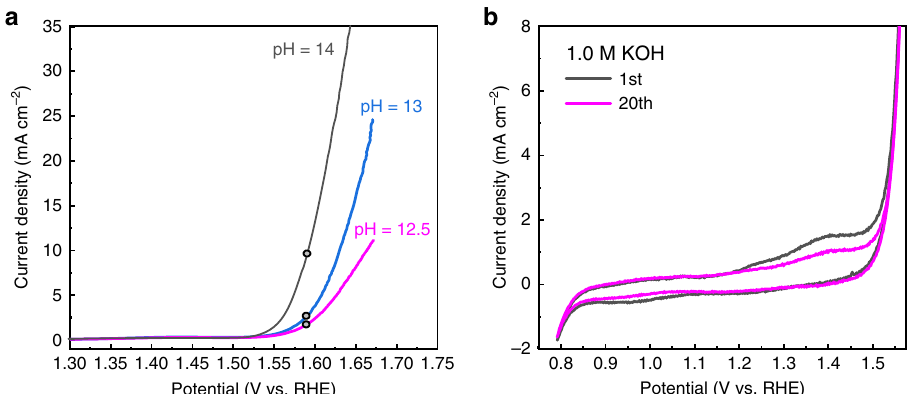
Fig. 1 OER activity of Li 2 Co 2 O 4 . a Polarization curves for Li 2 Co 2 O 4 in O 2 -saturated KOH (pH = 12.5 – 14) at a scan rate of 10 mV s − 1 . b Cyclic voltammograms of Li 2 Co 2 O 4 loading on carbon paper at a scan rate of 5 mV s − 1 for the 1st cycle (black) and the 20th